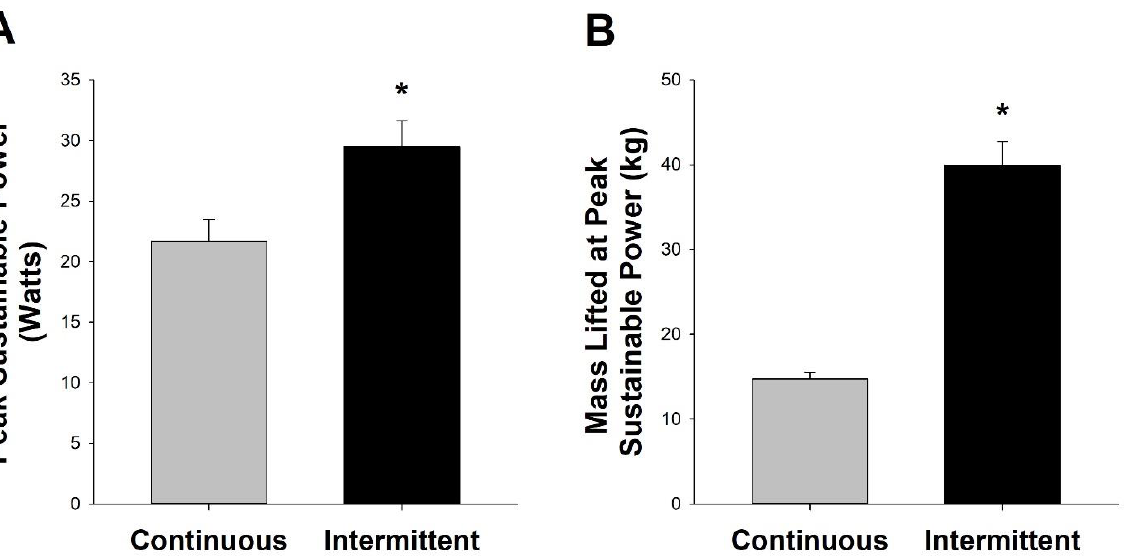
Figure 3. Impact of Interrepetition Rest on Peak Sustainable Power (P SUS ) during Single-Leg Knee Extension Resistance Exercise. ( A ) P SUS during 3 min of continuous (i.e., no rest between repetitions) and intermittent (i.e., 2 s rest between repetitions) knee extension exercise. ( B ) Mass lifted during trials eliciting P SUS . * Significantly different ( p < 0.05) from the continuous trial.